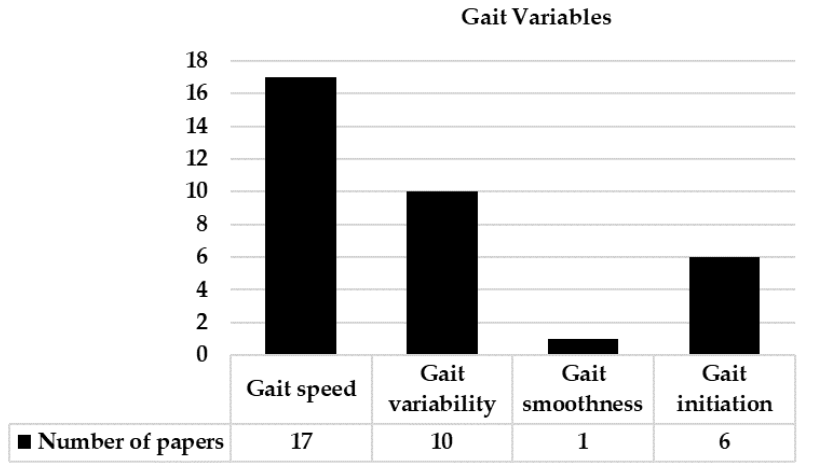
Figure 4. The number of papers for each gait variable.